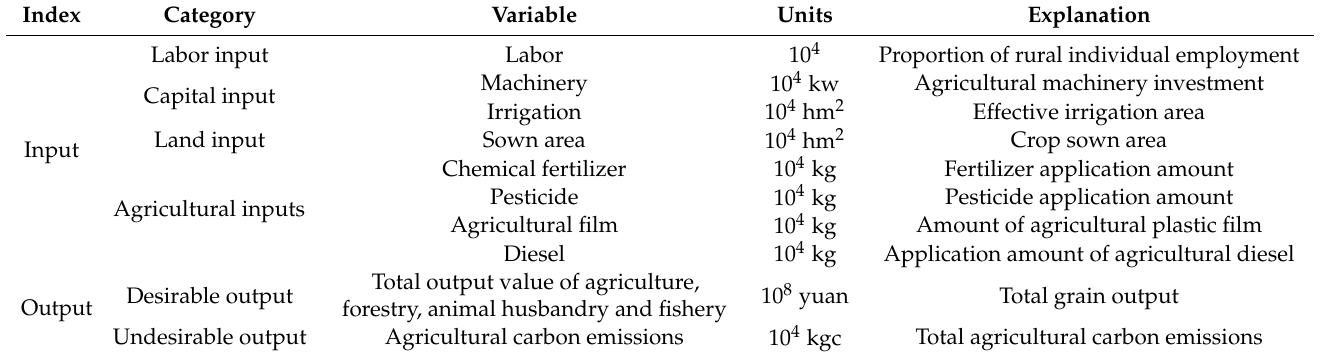
Table 3. The Undesirable Output SBM Model Index System for Measuring Agricultural Eco-Efficiency.